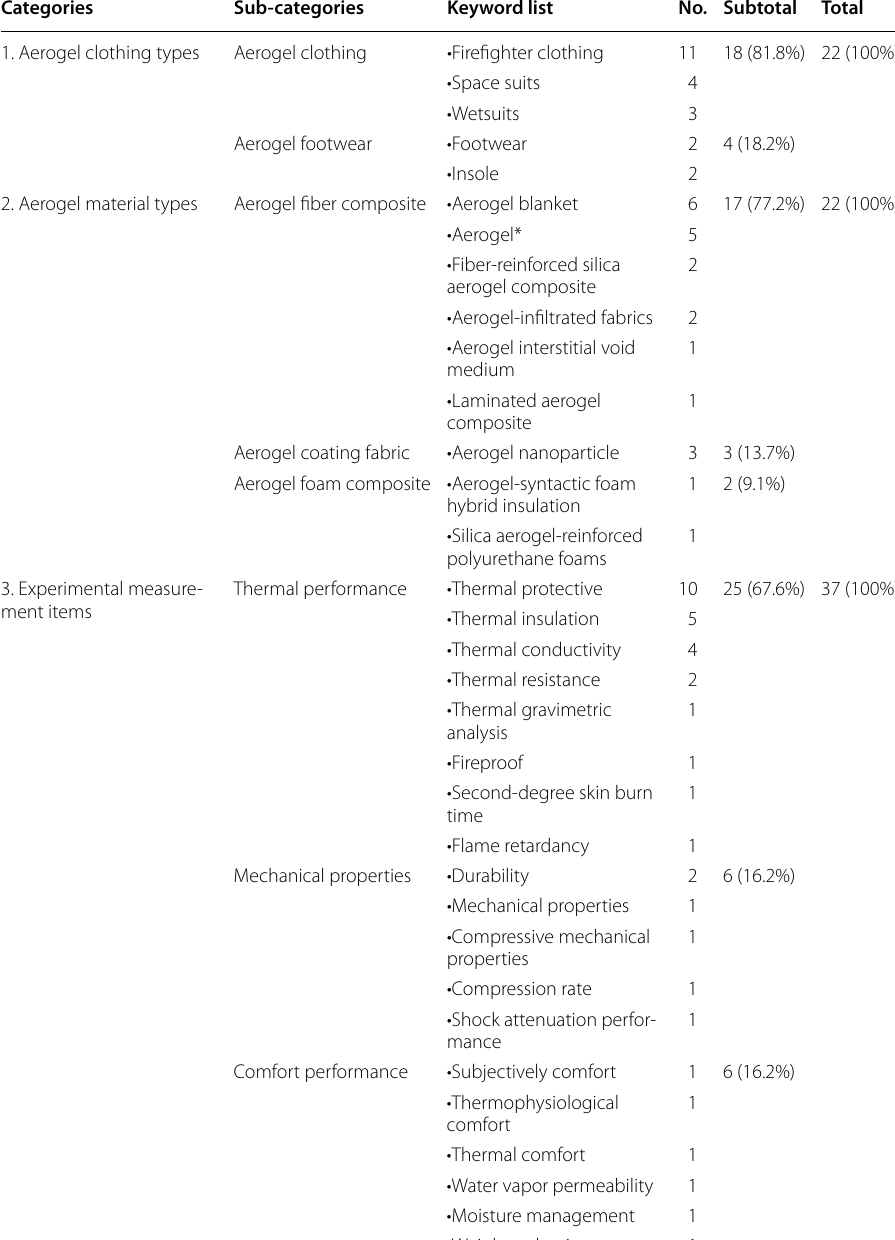
Table 1 Division of the 105 keywords into four